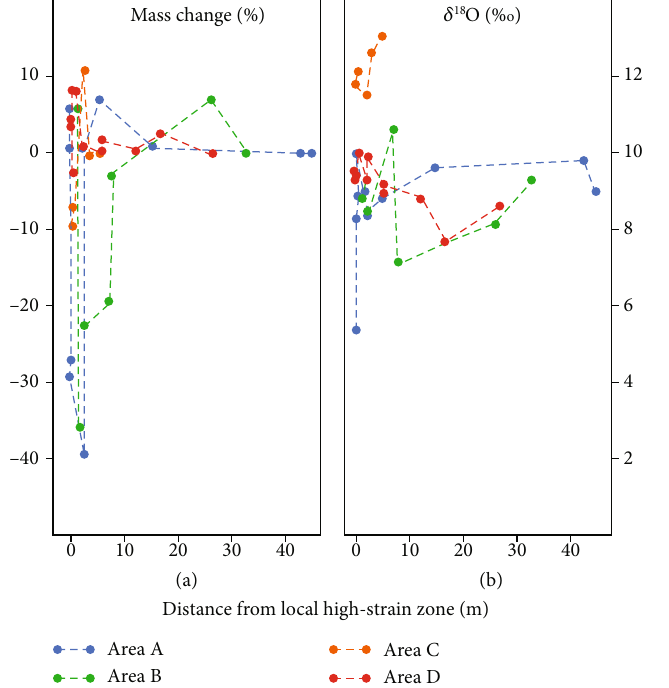
Figure 9: Mass changes (a) and δ 18 O values (b) against distance from local high-strain zones. The largest mass change occurs closer to the high-strain zones. Proximity to the local high-strain zones does not seem to a ff ect the δ 18 O